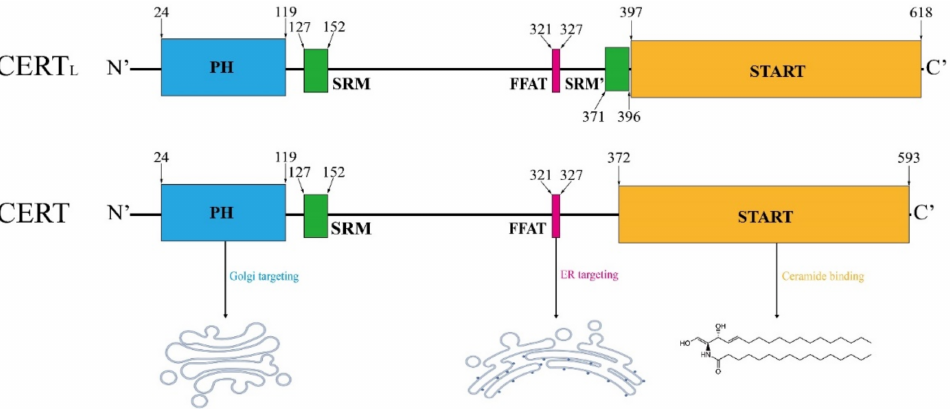
Figure 3. Schematic structure of CERT. The structural elements are colored as follows: Pleckstrin homology (PH) domain (blue), serine-rich motif (SRM, green), two phenylalanines in an acidic tract (FFAT) motif (pink), StAR-related lipid-transfer (START) domain (orange), major phosphorylation sites (red). The short-form CERT lacks a SRM in the proximity of START domain, as compared with the long-form variant. Amino acid sequence is adapted from